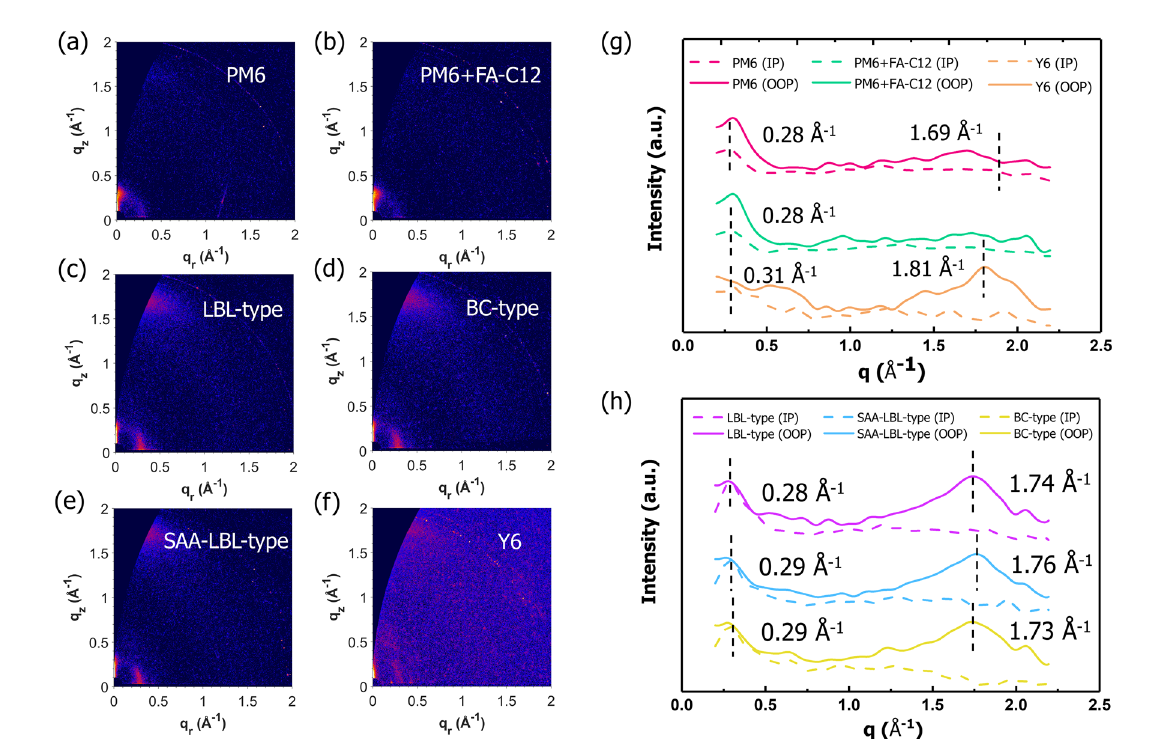
Fig. 6 The 2D GIWAXS images of a PM6 pristine film, b PM6 film with FA-C12, c LBL-type thin film, d BC-type thin film, e SAA-LBL-type thin film, f Y6 pristine film. The 1D X-ray profiles of the corresponding g PM6 (w/o FA-C12) and Y6 films and h BC-type, LBL-type and SAA- LBL-type PM6:Y6 thin